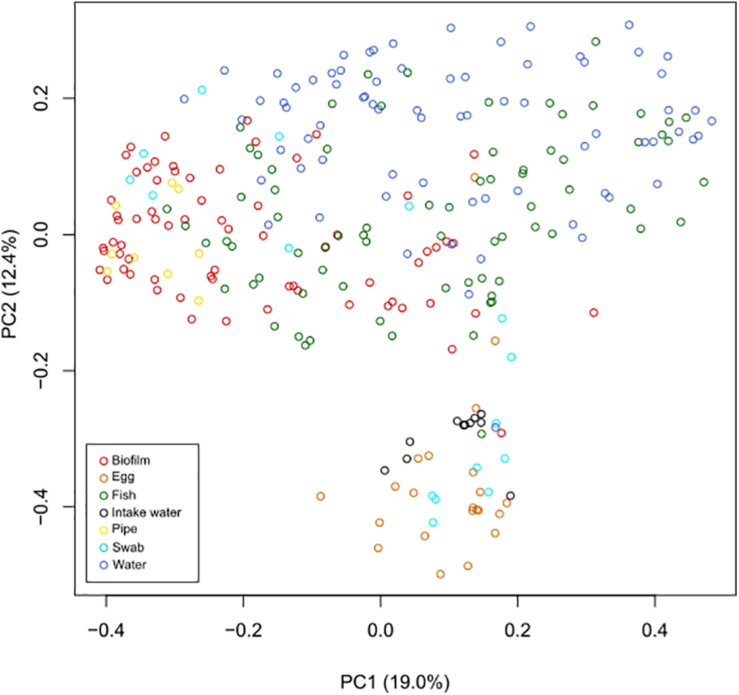
Principal coordinates analysis (PCoA) performed on all samples at genus level. Samples were compared using Bray–Curtis distance matrix, and the similarities were visualized in a PCoA plot. Samples of intake water and most egg samples formed a separate cluster, together with a few other samples. In addition, sampled tank water and samples comprising biofilms (from cable ties, tank walls, and drain pipes) also seemed to cluster separately, while sampled fish were more evenly distributed in the plot.